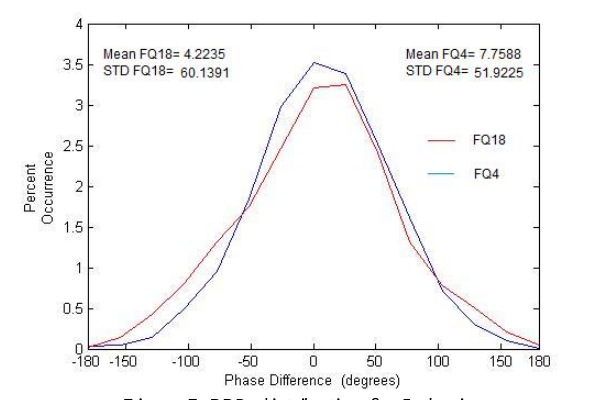
Figure 7. PPD distribution for Jack pine According to relatively low height range of jack pine,